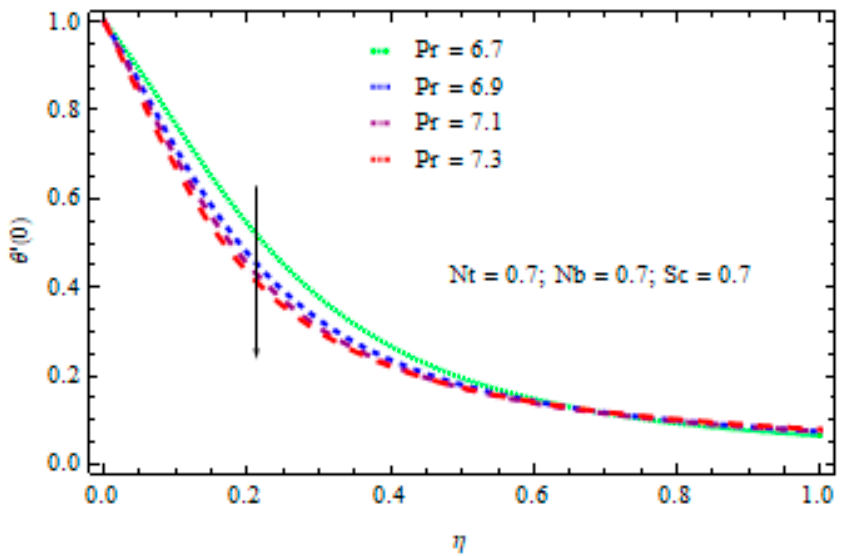
Figure 19. The impact of the Pr parameter on the heat transfer rate.